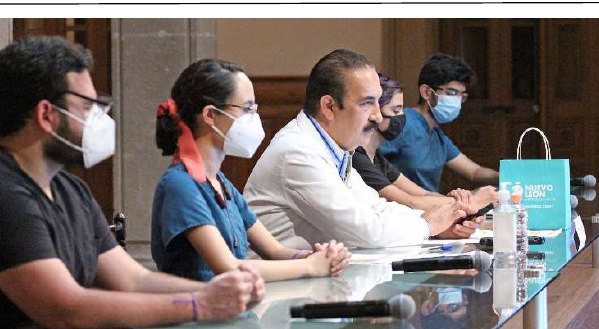
Figure 3. Event Organizers at the COVID-19 Press